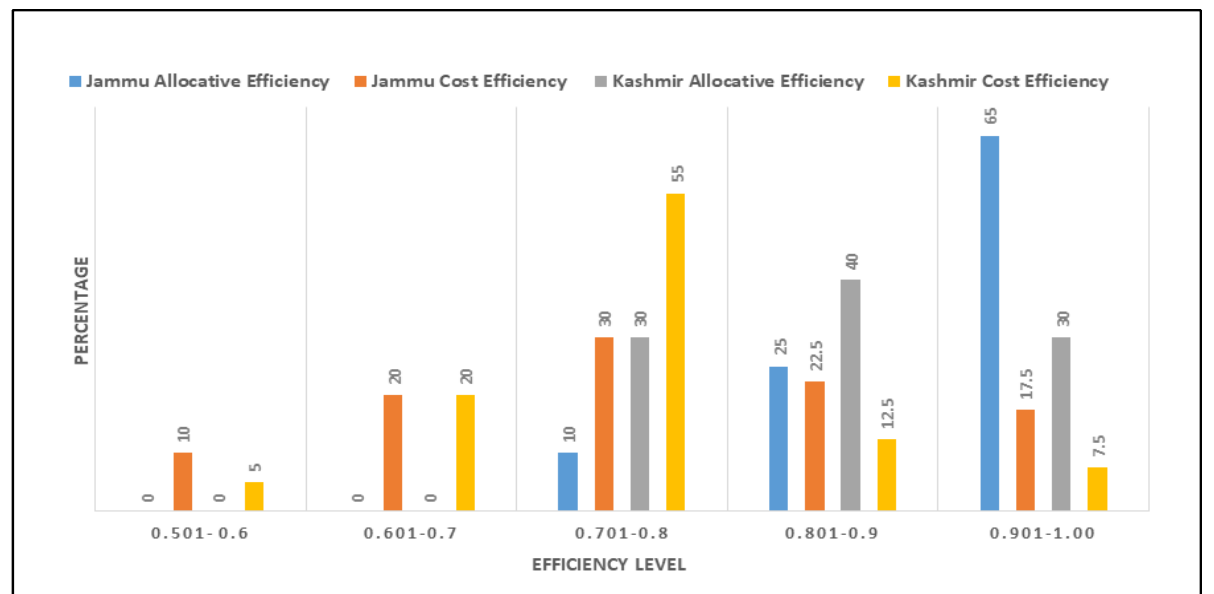
Figure 2. Distribution of allocative and cost efficiency measures. Table 6. Distribution of allocative and cost efficiencies of sample farms in the region.